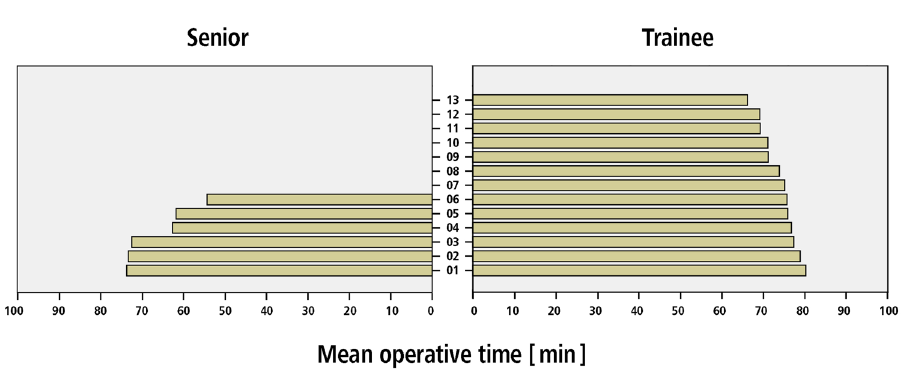
Figure 2. Number of THAs performed by each surgeon (six senior surgeons and 13 trainees) during the period of the study.